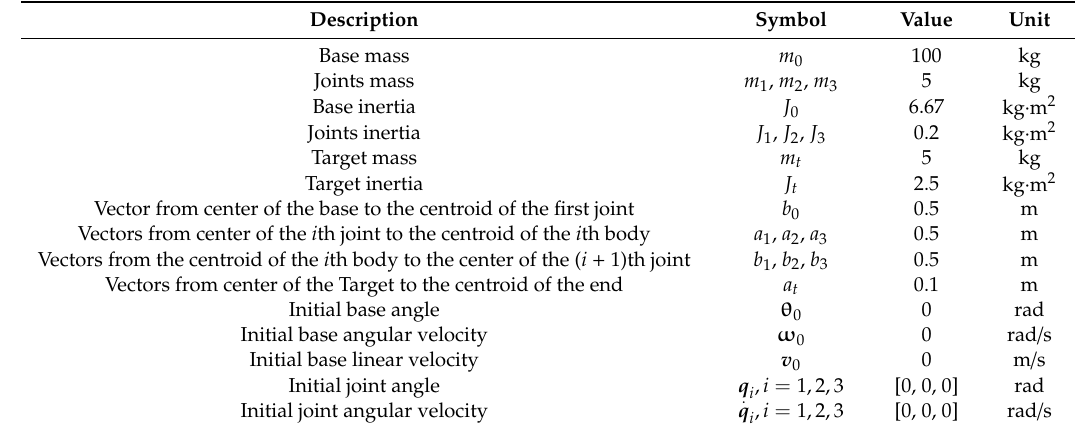
Table 1. The dynamic parameters of the space robot system.